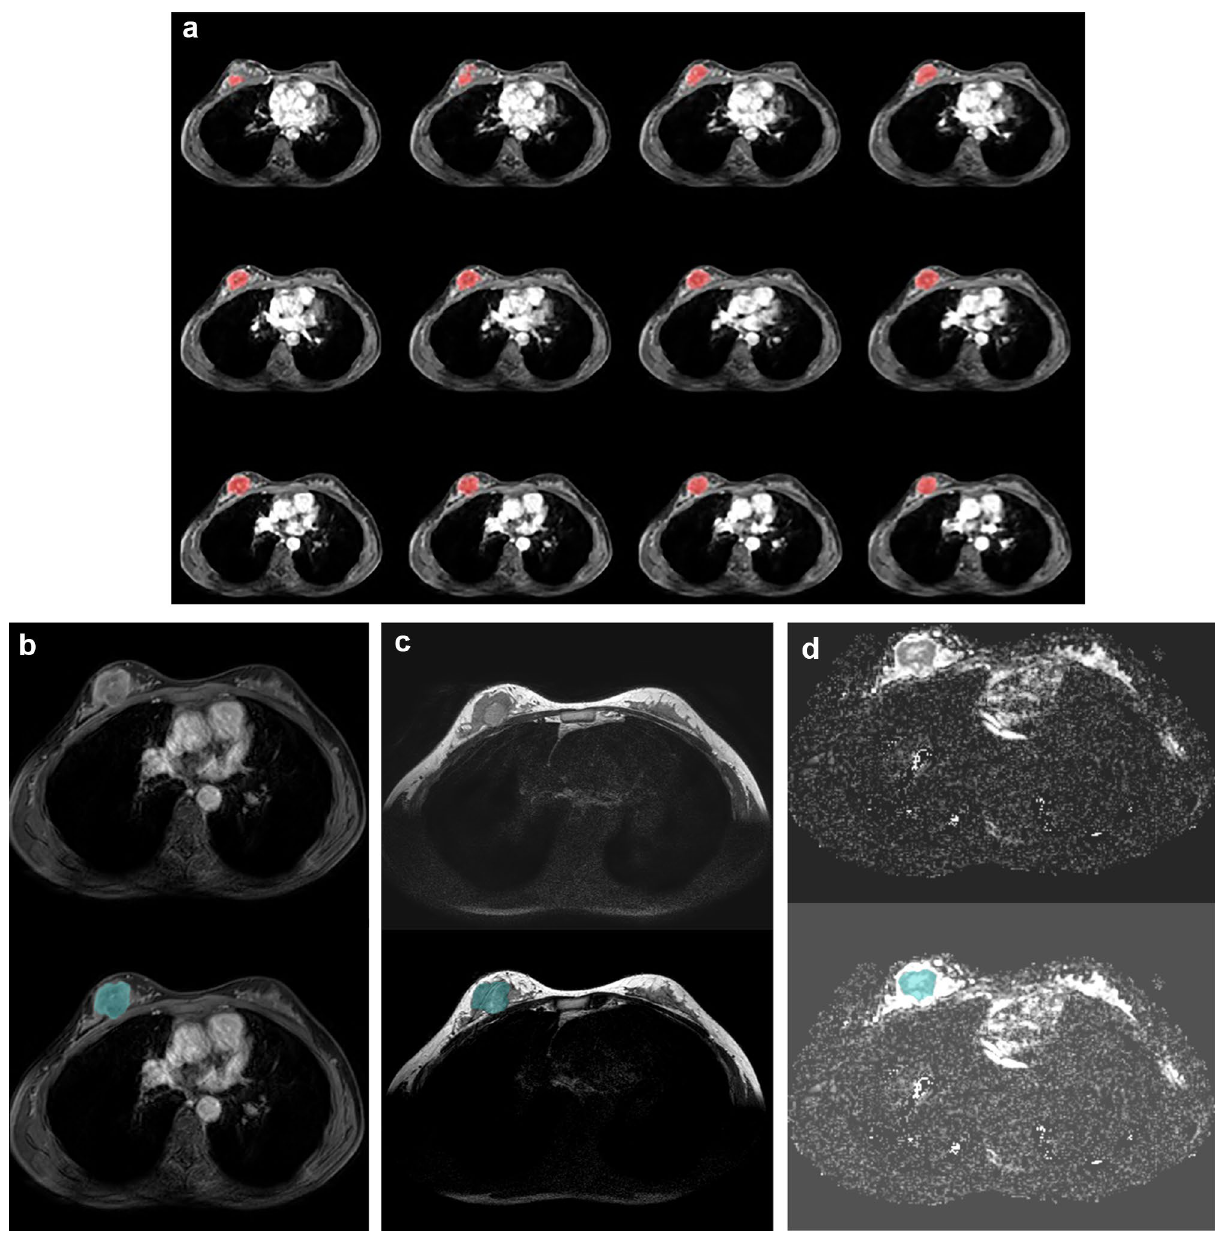
Figure 4. Texture analysis of invasive ductal carcinoma at 12 o’clock direction of right breast. Based on the VOI obtained from the perfusion parameters analysis ( a ), it was applied on subtracted early phase contrast enhanced T1WI ( b ), non-fat saturated T2WI ( c ), and ADC map ( d ). The color maps that do not match the tumor were manually modified using the original MR images of these